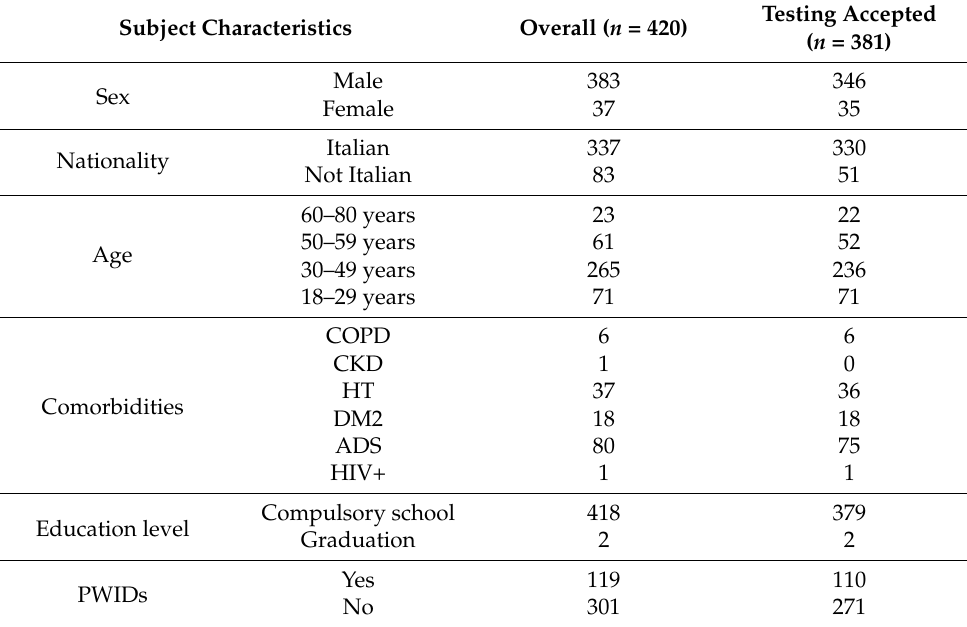
Table 1. Characteristics of the study population ( n = 420) and of the prisoners who accepted the Tu- berTest ( n = 381). ADS indicates anxious-depressive syndrome; COPD, chronic obstructive pulmonary disease; CKD, chronic kidney disease; DM2, type 2 diabetes mellitus; HIV, human immunodeficiency virus; HT, hypertension, PWIDs, people who inject